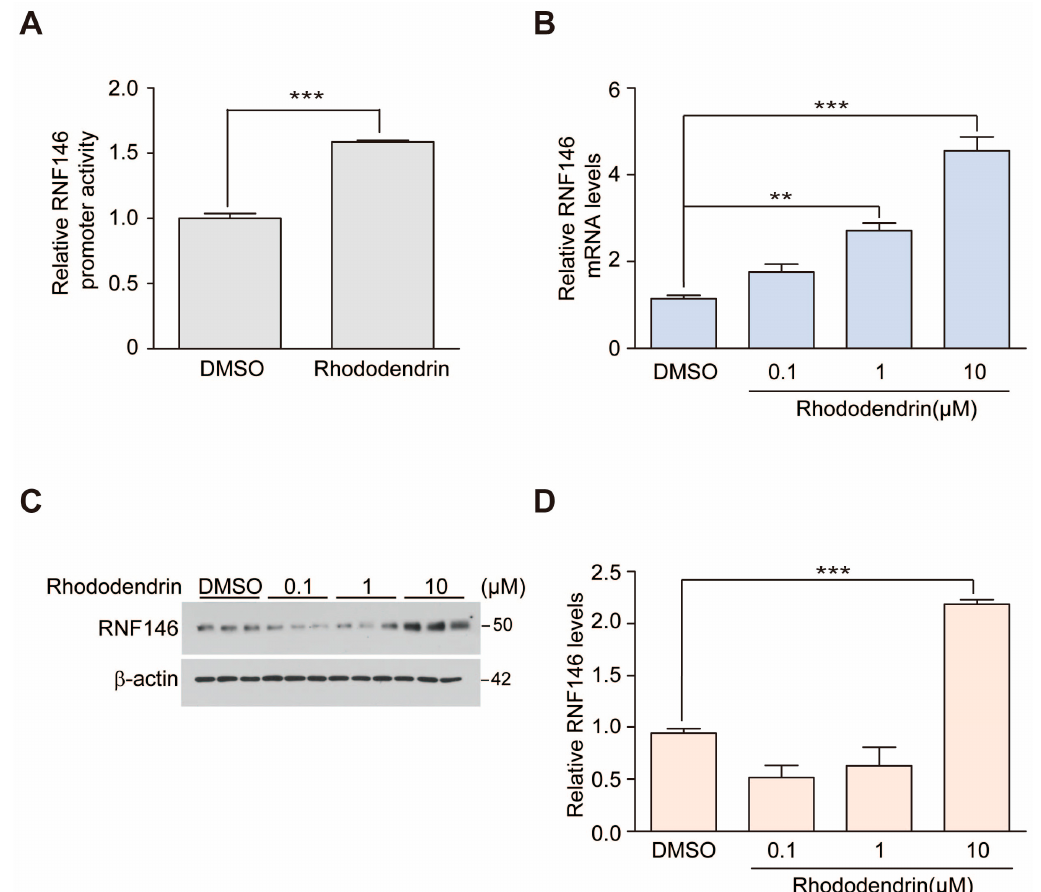
Figure 1. Rhododendrin increases RNF146 expression. ( A ) Quantification of relative RNF146 promoter activity in SH-SY5Y cells transfected with pGL3-RNF146-Luc and pRL-TK for 24 h, followed by treatment with 10 µ M of rhododendrin for 37 h ( n = 6 per group). ( B ) Quantification of relative RNF146 mRNA levels normalized to GAPDH in SH-SY5Y cells treated for 37 h with 0.1, 1, and 10 µ M of rhododendrin ( n = 3 per group). ( C ) Representative Western blot showing RNF146 expression in SH-SY5Y cells treated for 37 h with the indicated concentrations of rhododendrin (0.1, 1, 10 µ M). β -actin served as a loading control. ( D ) Quantification of relative RNF146 protein levels normalized to that of β -actin in SH-SY5Y cells treated for 37 h with 0.1, 1, and 10 µ M of the rhododendrin ( n = 3 per group). Data are expressed as mean ± SEM. ** p < 0.01 and *** p < 0.001, ANOVA test followed by Tukey’s post-hoc analysis.